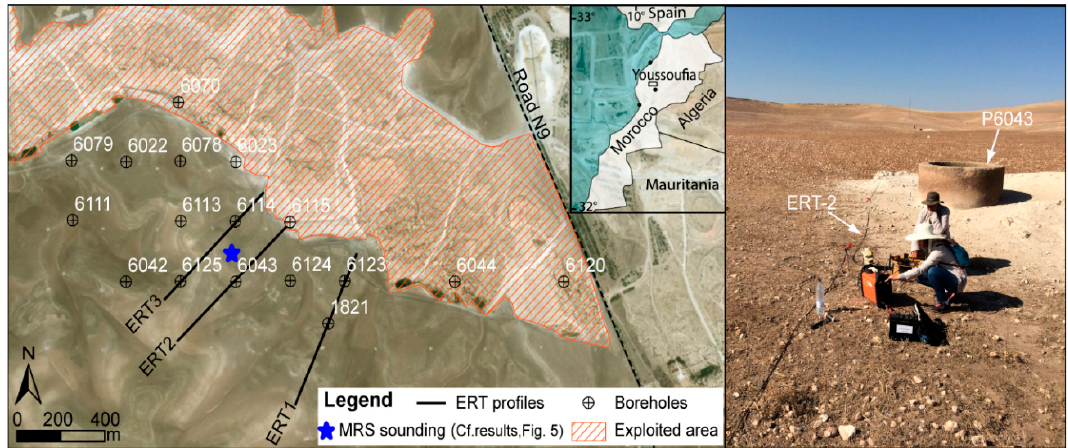
Figure 2. Location of geophysical surveys carried out in Youssoufia area and photograph showing a borehole intersected by the electrical resistivity tomography (ERT)-2 profile. borehole intersected by the electrical resistivity tomography (ERT)-2